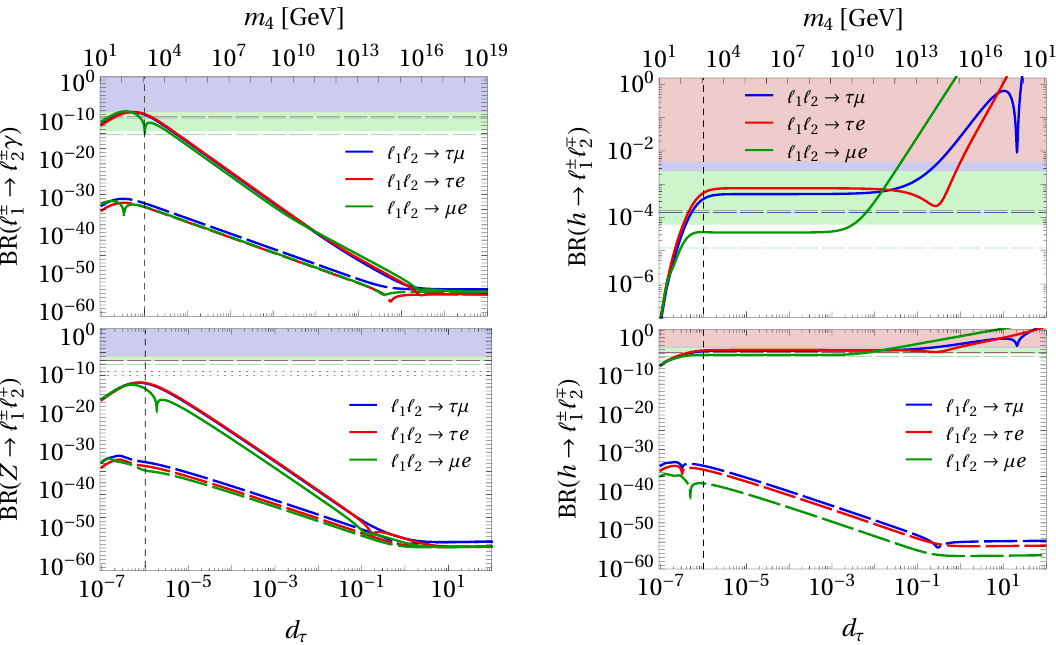
Figure 2 . The branching ratios as functions of the Yukawa coupling d τ . Full lines give the BRs computed with the contribution of all amplitudes; dashed lines represent the BRs computed only with the amplitudes that do not involve the charged scalars H ± . The shadowed bands are excluded by the present experimental data; the dashed/dotted horizontal lines show the future experimental sensitivities given in table 1. The colours of the shadowed bands coincide with the colours of the lines, viz. blue for ( ‘ ) = ( τ, µ ) , red for ( ‘ ) = ( τ, e ) , and green for ( ‘ ) = ( µ, e ) . The 1 , ‘ 2 1 , ‘ 2 1 , ‘ 2 vertical dashed lines mark the location of BP-1 of table 3. The upper-right panel is a zoom of the upper part of the bottom-right one. In the left panels, the blue lines almost always coincide with the red